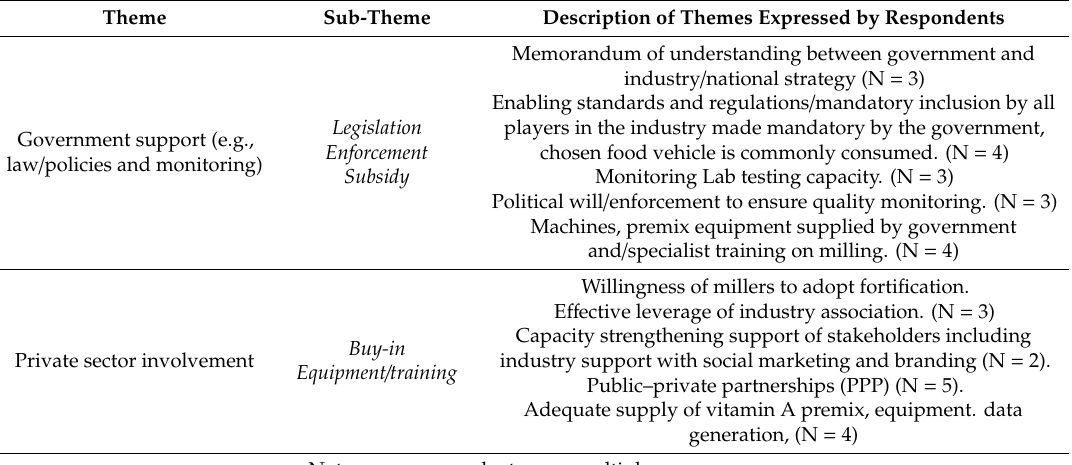
Table 5. Reasons for the success of fortification projects by theme (N =